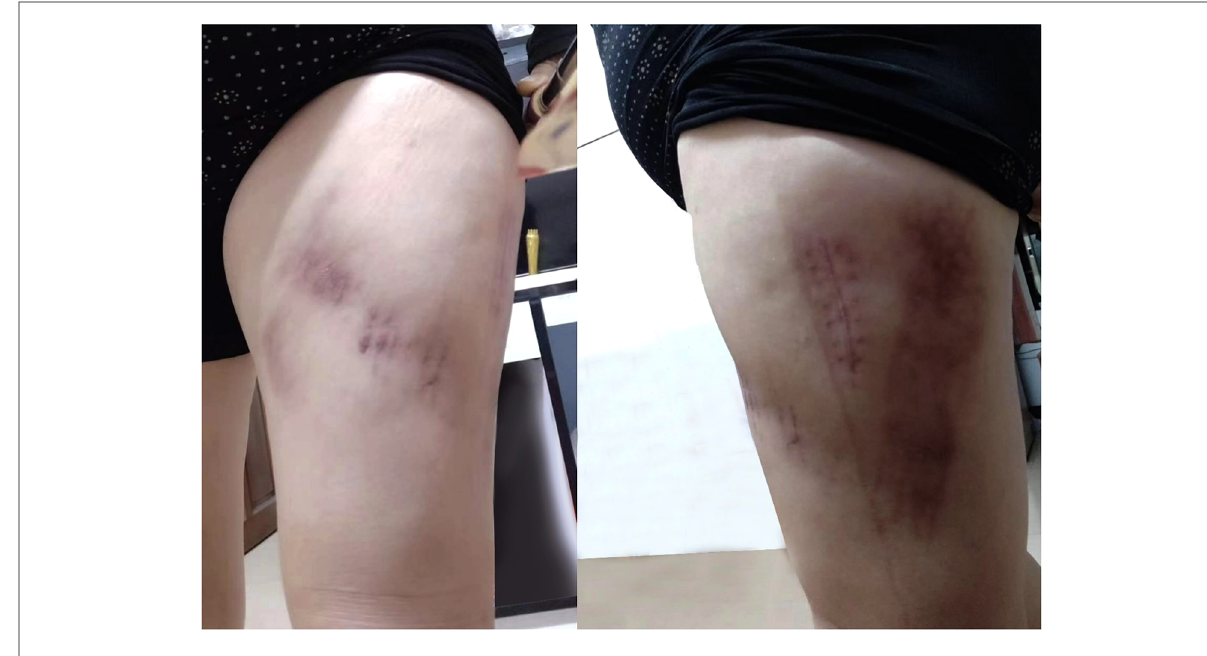
FIGURE 4 Clinical images after healing. Pain, swelling, and previous skin fl uctuations in the patient ’ s right leg